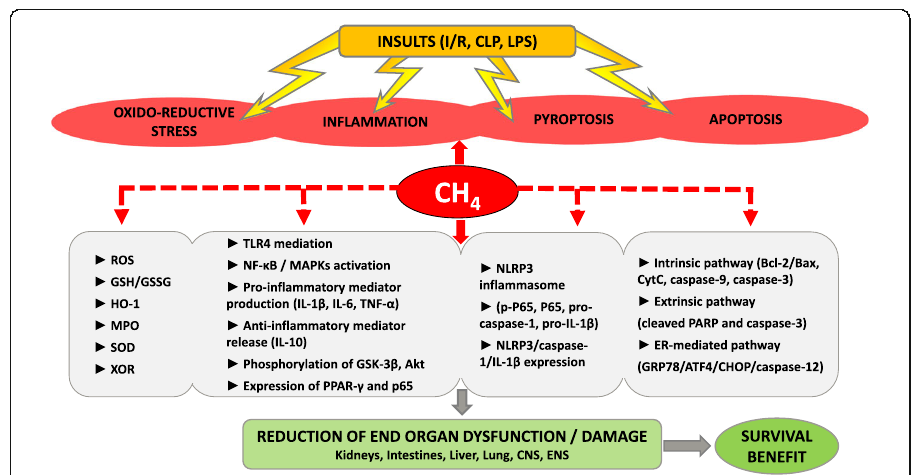
Fig. 1 Documented CH 4 -mediated mechanisms in experimental models of sepsis, endotoxemia and systemic inflammation. ATF4, activating transcription factor 4; Bax. Bcl-2-associated X protein; Bcl-2, B cell lymphoma 2; CHOP, C/EBP homologous protein; CLP, cecal ligation and puncture; CNS, central nervous system; CytC, cytochrome C; ENS, enteric nervous system; ER, endoplasmic reticulum; GRP78, glucose-regulated protein 78; GSK-3 β , glycogen synthase kinase 3 beta; GSH, glutathione; GSSG, glutathione disulphide; HO-1, heme oxygenase 1; IL-1 β , interleukin 1 beta; IL-6, IL-10, interleukin 6 and interleukin 10, respectively; I/R, ischemia/reperfusion; LPS, lipopolysaccharide; MAPKs, mitogen-activated protein kinase; MPO, myeloperoxidase; NF- κ B, nuclear factor- κ B; NLRP3, NOD-like receptor